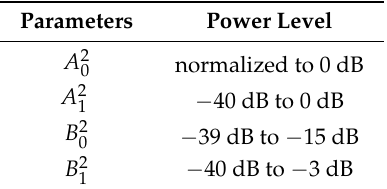
Table 1. The possible relative power of the received LOS and MP signals by a dual-polarization antenna.